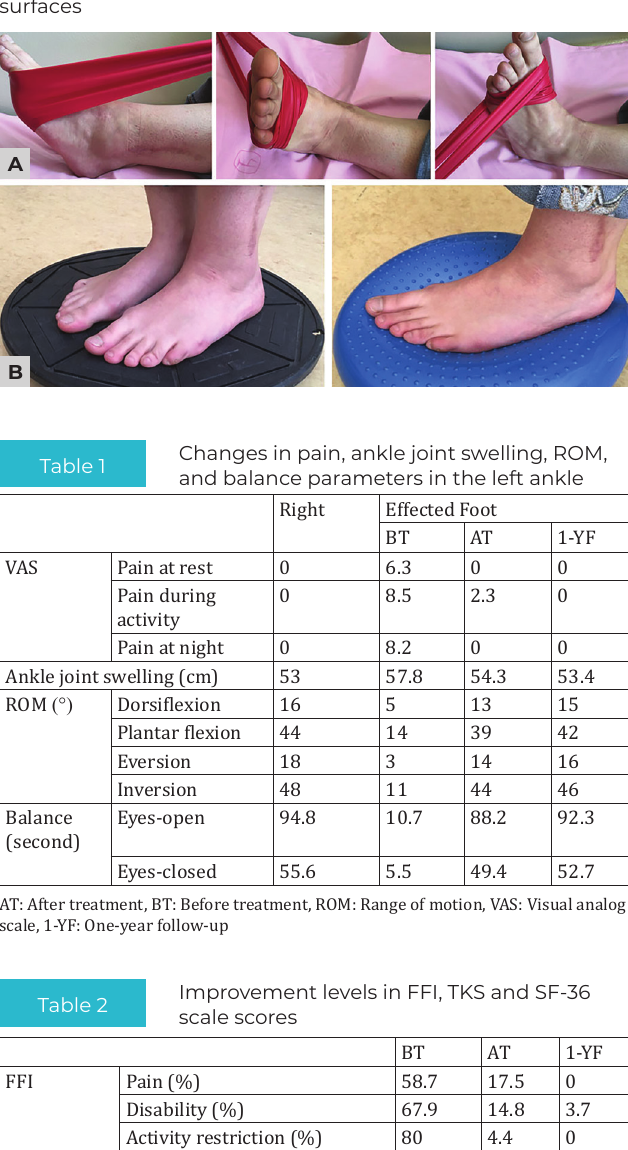
Figure 3 A -Resistance strengthening exercises with Thera- band®, B : Balance and proprioceptive training on uneven